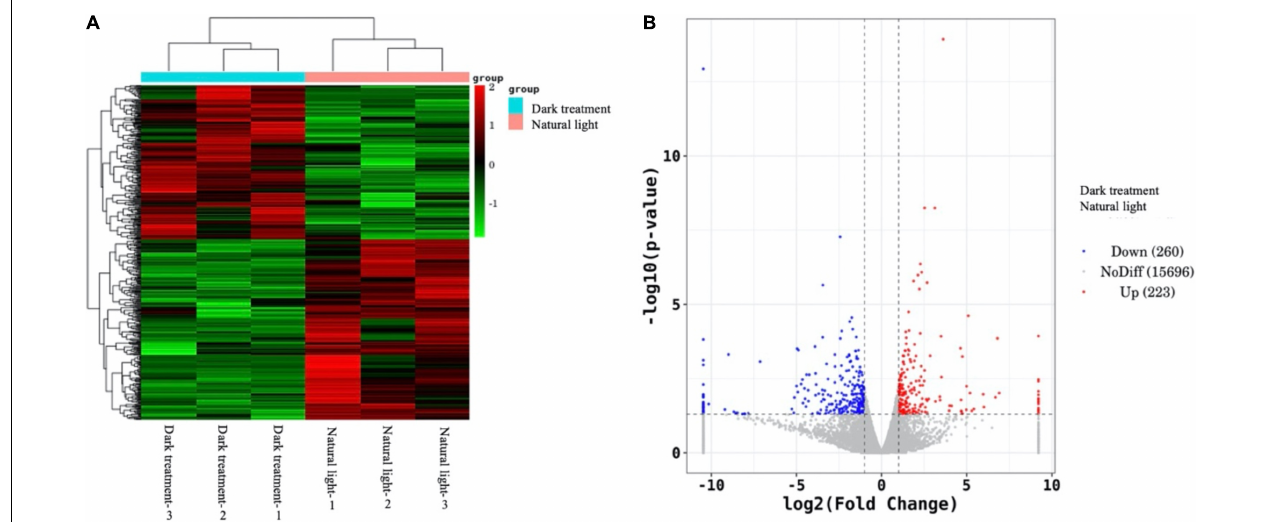
FIGURE 4 | Difference analysis of expressed genes between the natural light group and dark treatment group in the hepatopancreas of Litopenaeus vannamei . The heatmap plot (A) denotes clusters of samples, while the volcano plot (B) represents statistics of the total expressed genes that include upregulated genes (indicated as red dots), no difference genes (indicated as gray dots), and downregulated genes (indicated as blue dots).